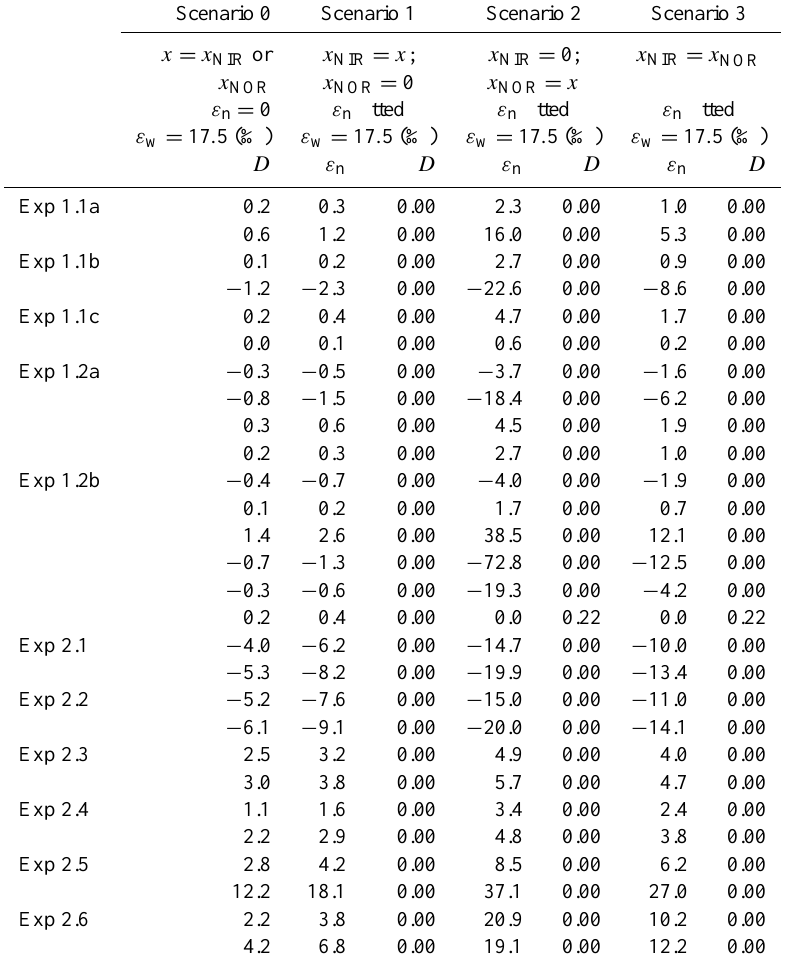
Table 4. Oxygen fractionation model based on the results obtained ( δ 18 O(N 2 O)) and isotope exchange ( x) determined by (cid:49) 17 O method 0 and ε w = 17.5‰ determined from Exp 1 data (Table 3). Scenarios with varied ε n values and x NIR or x NOR (fraction of isotope exchange associated with NIR or NOR) are compared. D is the difference between measured δ 18 O of N 2 O and the calculated δ 18 O of N 2 O in a particular